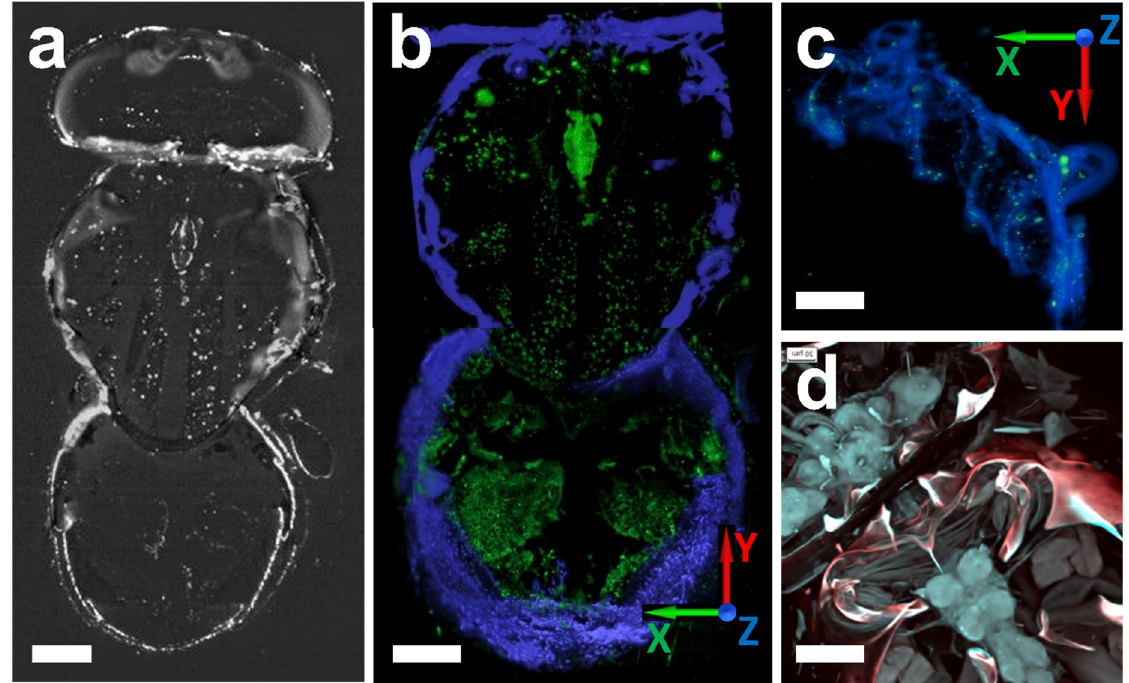
Figure 4. MAXWELL images show a drosophila fly with SciNPs (NaGdF 4 :Eu) administrated to delineate the tracheal and intestine features. The 3D image, ( b ), was constructed by stacking single slice images such as that of ( a ). Note that the head part is not reconstructed in ( b ). The skeleton (blue) is visible due to X-ray autofluorescence. The segmentation of autofluorescence and SciNPs are based on their intensities. ( c ) 3D reconstructed MAXWELL image of an entire Drosophila larva. ( d ) Confocal laser scanning microscopy of the same Drosophila specimen exhibits high contrast but the visibility of the SciNPs is much reduced. Scale bars: ( a , b ) and ( d ) 100 µm; ( c ) 50